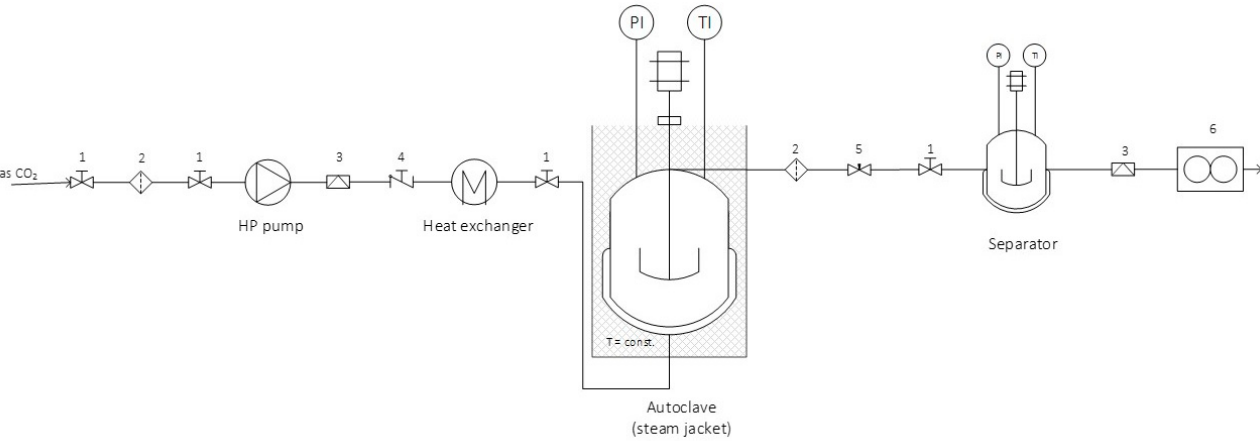
Figure 1. Supercritical fluid extraction system: 1—valve, 2—HP filter, 3—rupture disk, 4—one-way valve, 5—regulating valve, and 6—flowmeter [18].